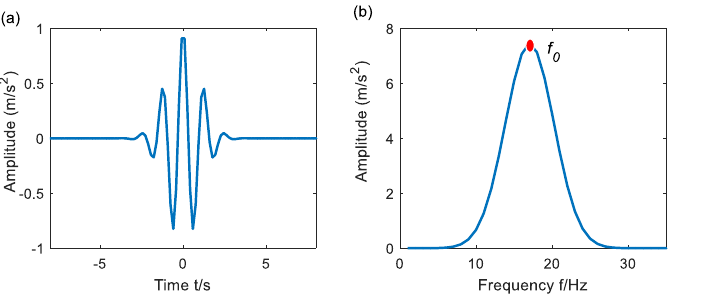
Figure 11. An example of Morlet wavelet: ( a ) time-domain wavelet; ( b ) frequency-domain wave-